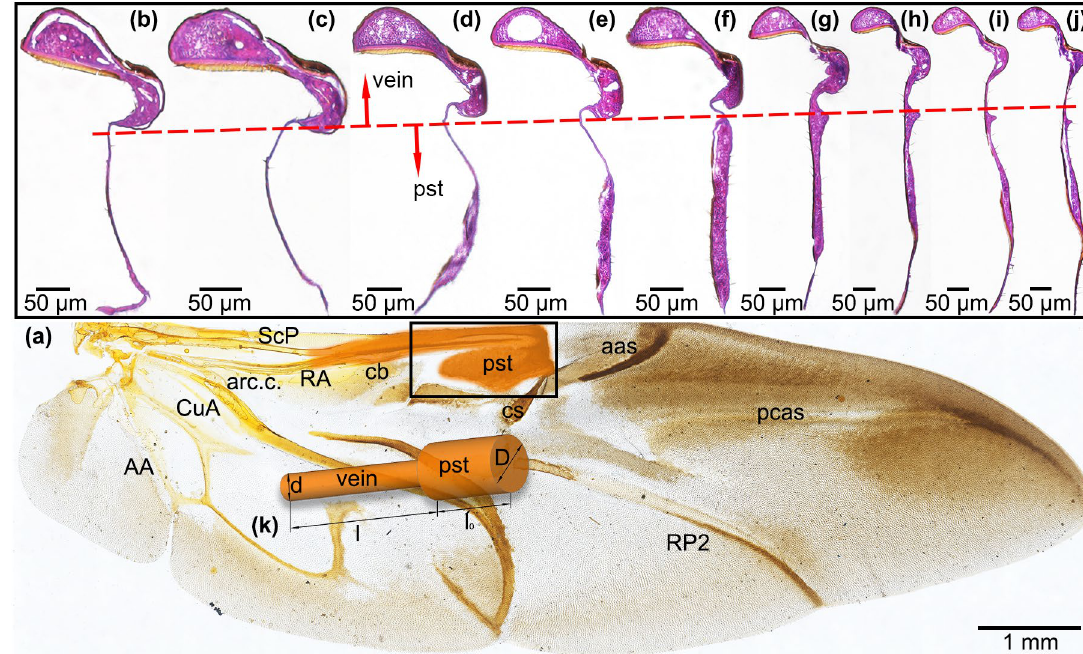
Figure 1. The morphology of the hind wing of H. axyridis is composed of a wing membrane, veins and a pst. ( a ) H. axyridis hind wing. Scale bar: 1 mm. ( b – j ) Cross-sectional structures of psts. Scale bar: 50 μm. ( k ) Simplified model of the veins and pst based on the location marked in brown. ScP: subcosta posterior. RA: radius anterior. RP: radius posterior. RP2: radius posterior 2. MP1 + 2: media posterior 1 + 2. AA: anal veins. CuA: cubitus anterior. cb: costal bar. arc.c.: complex arculus. pst: pterostigma. ams: anteromedian sclerotization. cs: central sclerotization. aas: antero-apical sclerotization. pcas: postcosto-apical